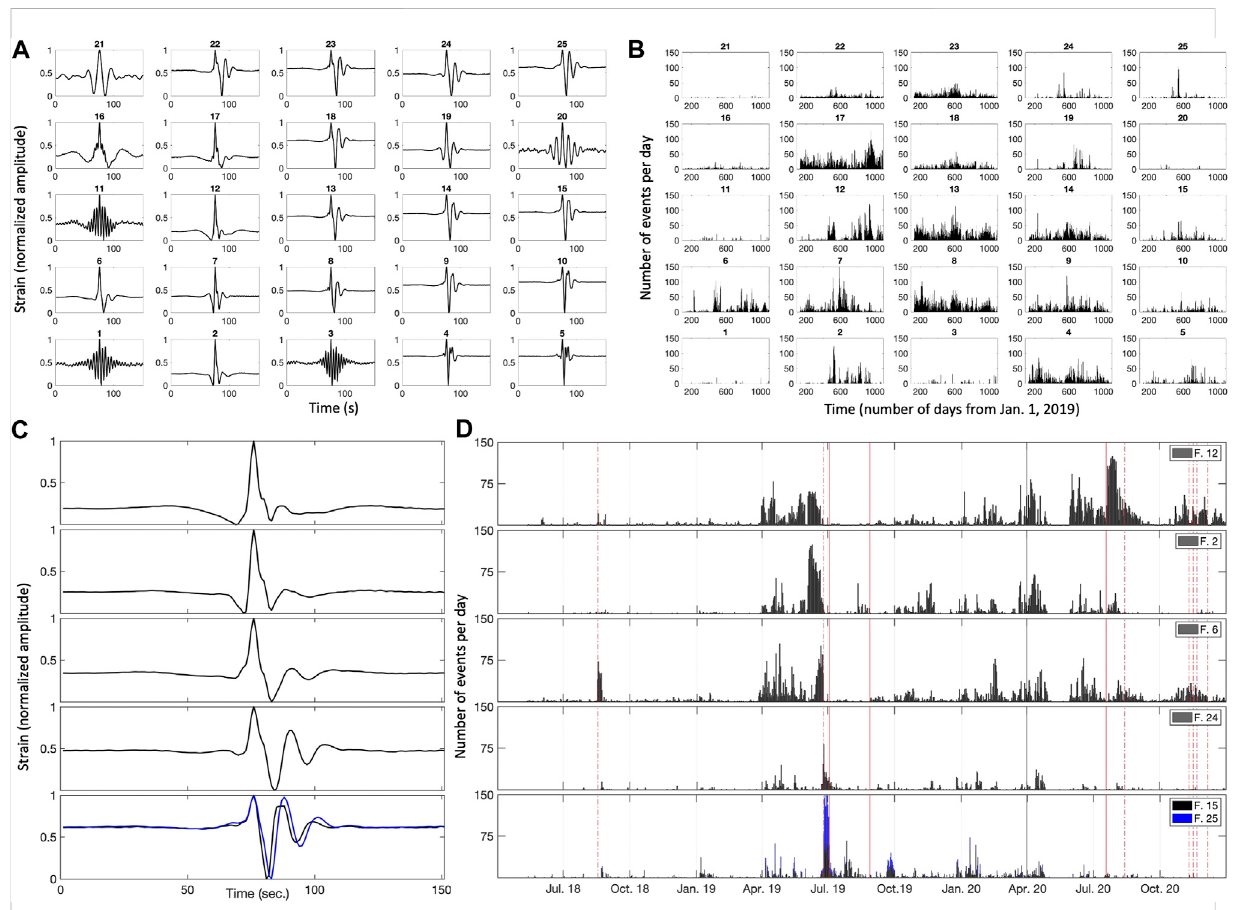
FIGURE 11 SOM cluster of families found in May 2018-December 2020 (A) Normalized stacked waveforms belonging to the i th node of the SOM map (B) Temporalhistogramsofcumulativenumberofeventsperdaybelongingtothe i thnodedeterminedbytheSOMalgorithm (C,D) Normalizedstacked waveforms and histograms of VLP data for noticeable families: black solid line marks the occurrence of the hybrid events on 31 March 2020; red dashed lines mark major explosions; the two red vertical solid lines mark the two paroxysmal